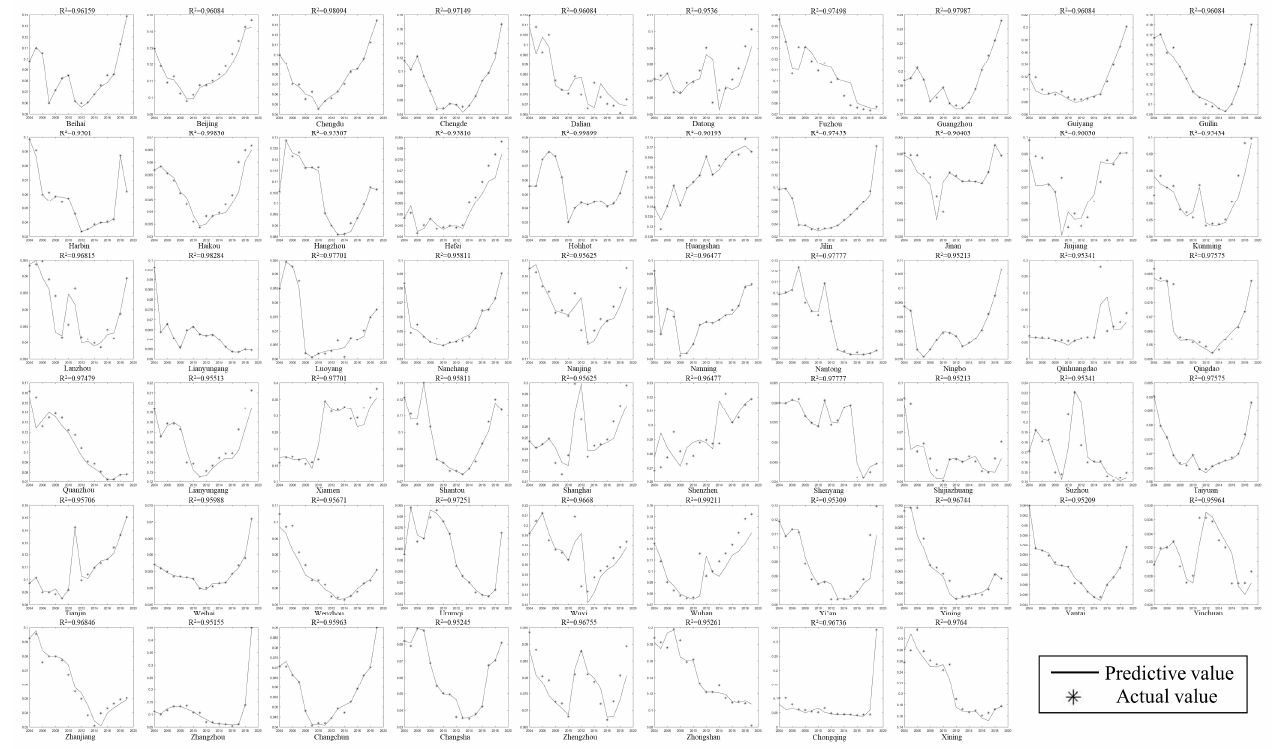
Figure 4. Accuracy tests of the BP neural network model.